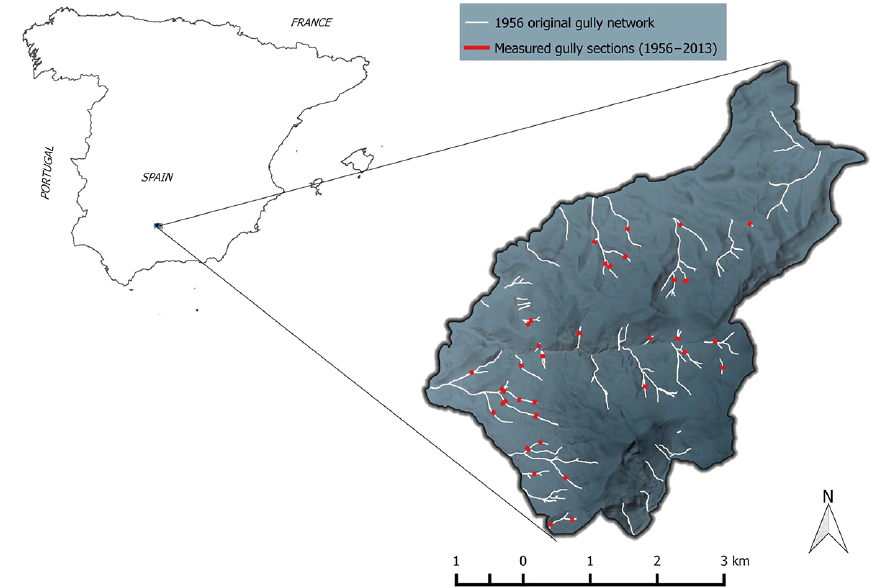
Figure 1. Site location with details of the original gully network and measured gully